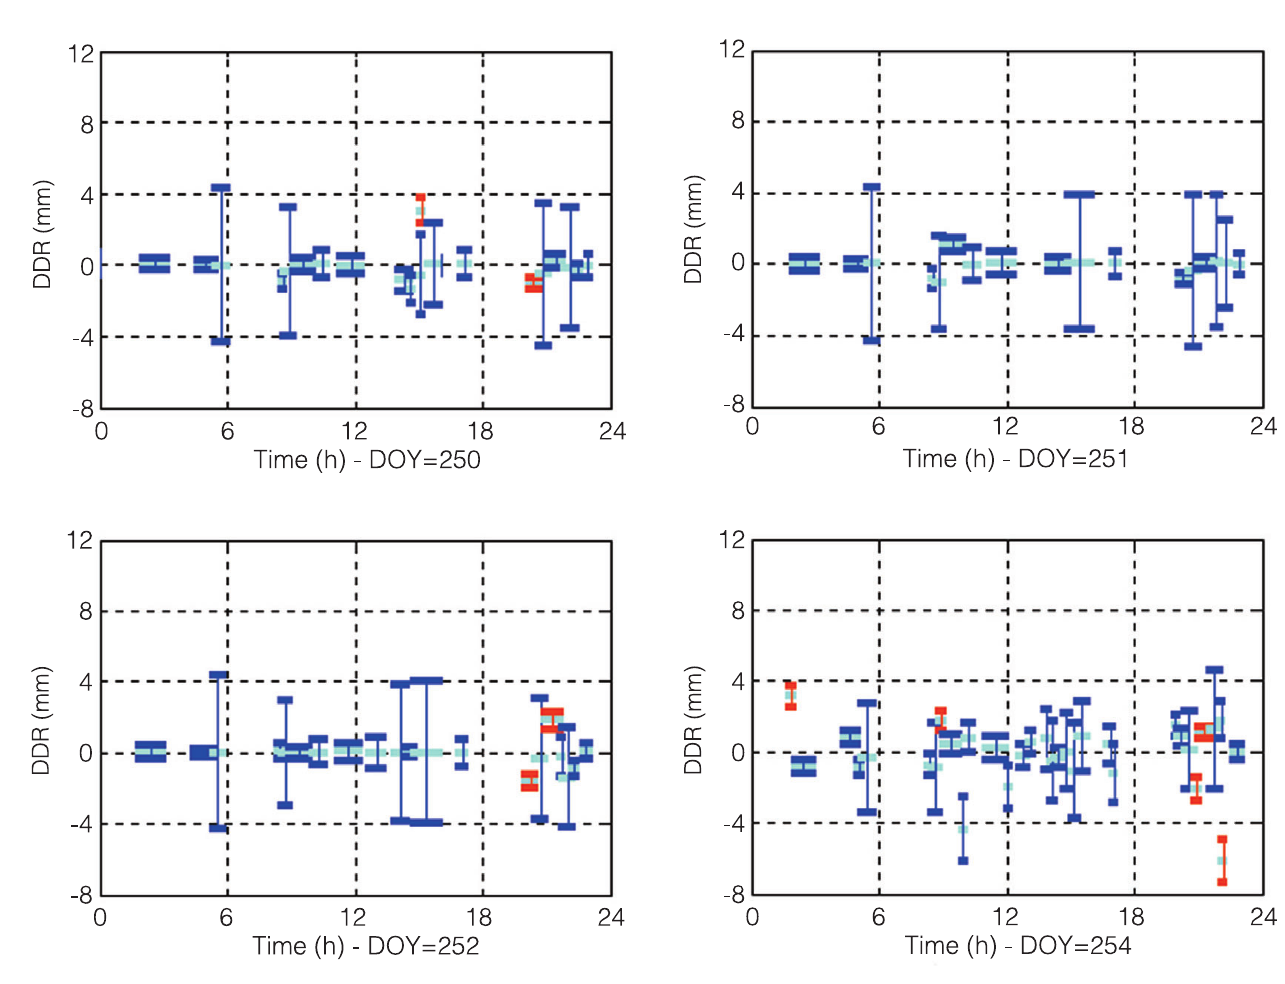
Fig. 1. Double differences residuals versus time for DOY: 250, 251, 252 and 254 of the year 1999 for the GPS stations Padua and Medicina (Italy). Lines: cyan-mean DDR; blue-standard deviation; red-anomalous